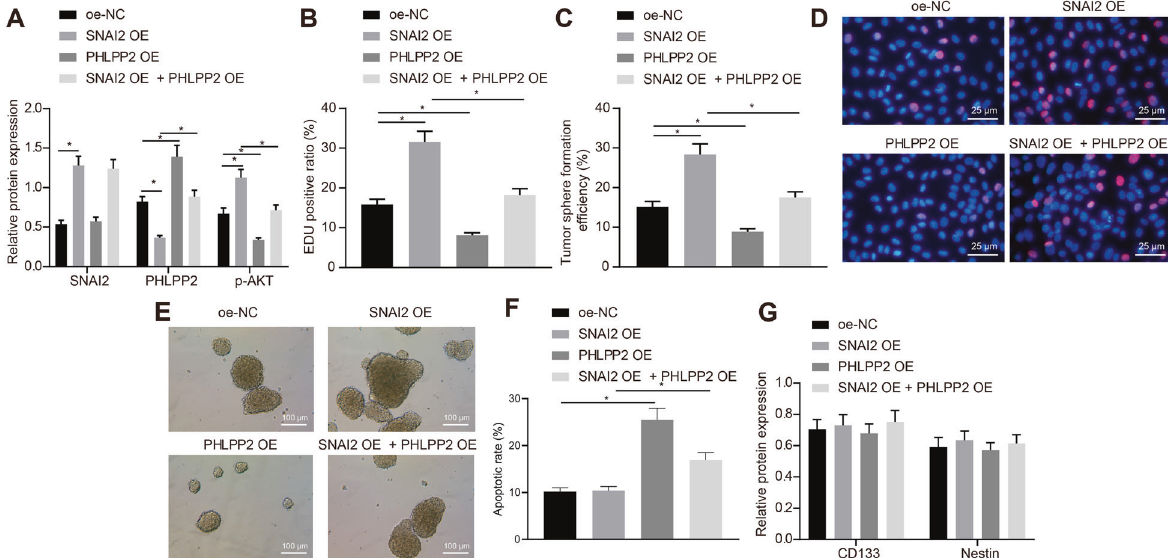
Fig. 5 SNAI2 promotes the proliferation of GSCs by inhibiting PHLPP2 to activate the Akt pathway. A The p-Akt and PHLPP2 level in the presence of oe-NC, oe-SNAI2, oe-PHLPP2, and oe-SNAI2 + oe-PHLPP2 as determined by Western blot assay. B Statistics of EdU-positive cells in GSCs in the presence of oe-NC, oe-SNAI2, oe-PHLPP2, and oe-SNAI2 + oe-PHLPP2 as determined by EdU assay. C Statistics of cell sphere formation ef fi ciency of GSCs in the presence of oe-NC, oe-SNAI2, oe-PHLPP2, and oe-SNAI2 + oe-PHLPP2 as examined by spheroid formation assay. D Representative images of EdU-positive cells in GSCs. E Representative images of sphere formation in GSCs. F The apoptotic rate of GSCs in the presence of oe-NC, oe-SNAI2, oe-PHLPP2, and oe-SNAI2 + oe-PHLPP2 as examined by fl ow cytometry. G The expression of CD133 and Nestin on the surface of GSCs in the presence of oe-NC, oe-SNAI2, oe-PHLPP2, and oe-SNAI2 + oe-PHLPP2 as examined by immuno fl uorescence. * p < 0.05 vs. GSCs treated with oe-NC, si-NC, oe-SNAI2, or oe-PHLPP2. Each cell experiment was repeated three times independently. constructed an overexpression plasmid of PHLPP2. Western blot the above data indicates that the transcription factor SNAI2 further assay was performed and the results revealed that the p-Akt level activates the Akt pathway by downregulating PHLPP2. was increased, while the expression of PHLPP2 was decreased by oe-SNAI2 when compared with oe-NC with an opposite trend SNAI2 promotes the proliferation of GSCs by inhibiting observed in response to oe-PHLPP2. Overexpressed PHLPP2 was PHLPP2 to activate the Akt pathway found to reverse the effects of oe-SNAI2 on PHLPP2 and p-Akt level To verify the function of the transcription factor SNAI2 activation of (Figs. 5A and S1C). As shown in the EdU assay, the viability of the the Akt signaling pathway by inhibiting PHLPP2 in GSCs, we